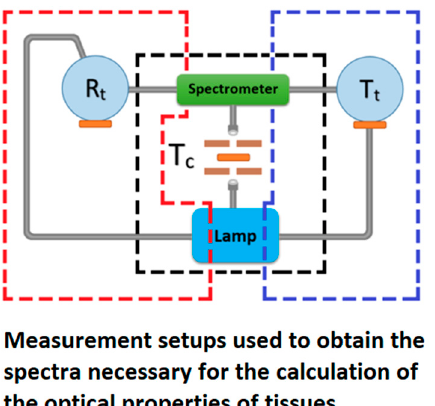
Figure 2. Schematic of the measurement setups to obtain T t , R t and T c spectra.